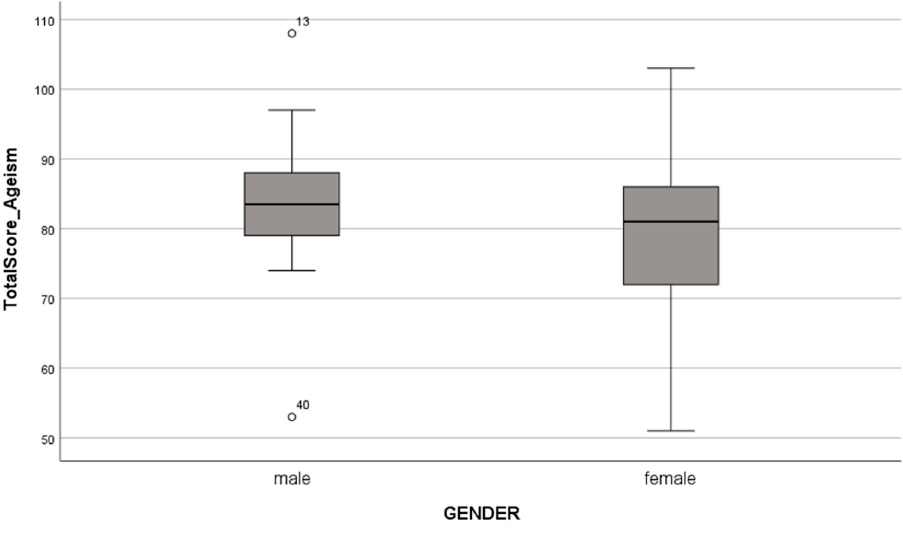
Figure 1. A box plot of the relationship between ageism score and participant gender.